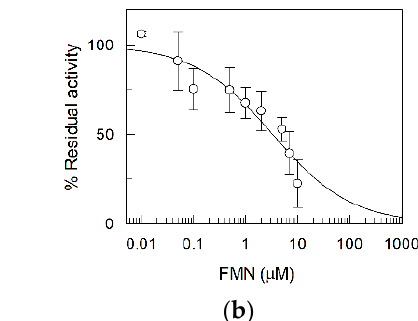
Figure 5. Effect of various compounds on riboflavin uptake. ( a ) Transport was measured as described in Materials and Methods. 10 µM FAD or 10 µM FMN or 100 µM lumiflavin or 10 mM Pyridoxal 5 ′ -phosphate (PLP) or 1 mM N-Ethylmaleimide (NEM) were added 1 min before the labeled substrate. Percent of residual activity was calculated for each experiment with respect to the control sample (without added inhibitor, referred as 100%); ( b ) dose-response curve for the inhibition of RFVT2 transport activity by FMN was obtained adding FMN at the indicated concentrations 1 min before the labeled substrate. riboflavin transport was stopped after 30 min. The values are means ± SD from three experiments. Statistics was performed using Student’s t -test (* p < 0.05).